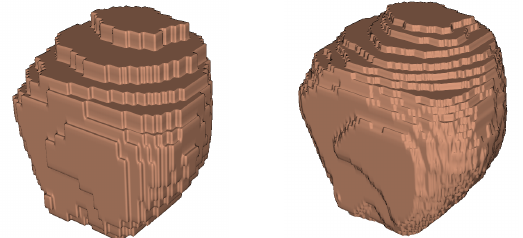
Figure 5. Mask predicted by a prostate segmentation CNN and upscaled along the z-axis three times using: nearest-neighbor interpolation ( left ), and Neural Resolution Enhancement ( right